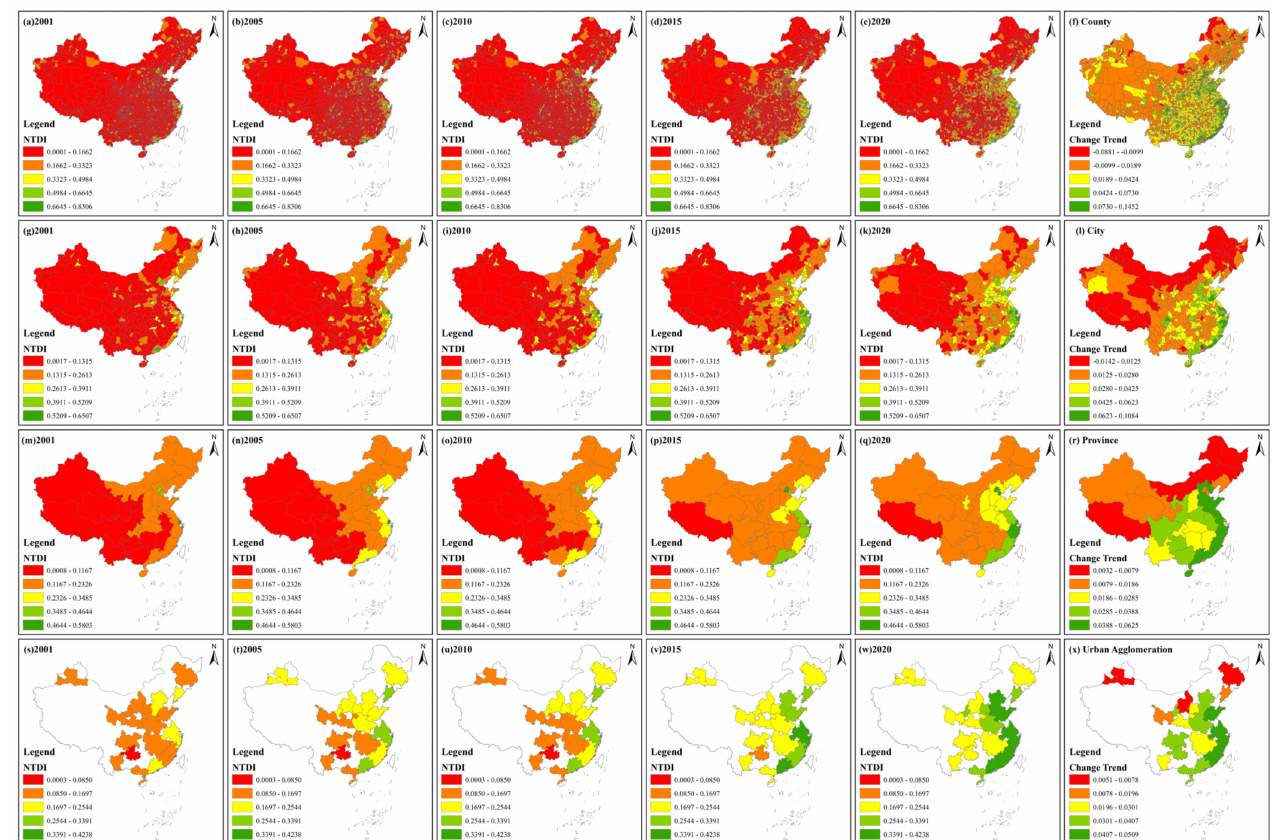
Figure 4. Spatial distribution and change trend of the NTDI from 2001 to 2020 at different scales. ( a – e ), ( g – k ), ( m – q ) and ( s – w ) display the spatial distribution of the NTDI at the county, city, province and urban agglomeration scales, respectively. ( f , l , r , x ) show the change trend of the NTDI at the four